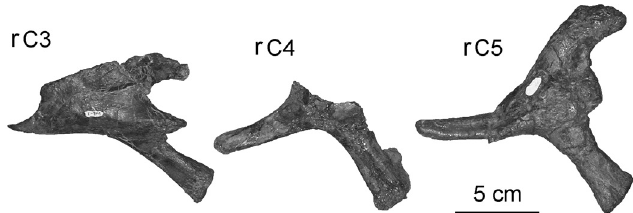
Figure 6. Cervical ribs C3–C5, right side. Vagaceratops irvinensis , CMN